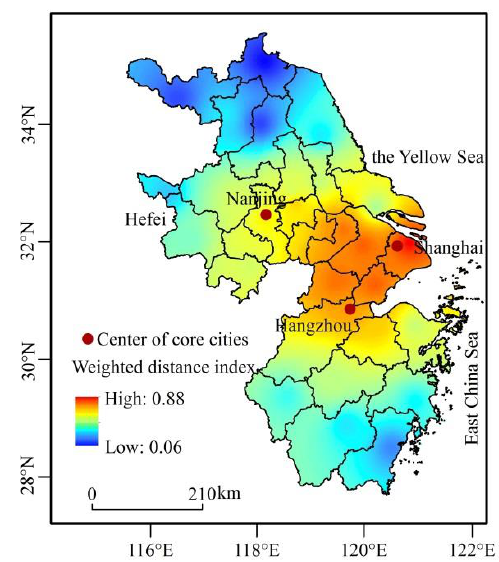
Figure 2. The spatial interpolation of weighted distance index Weighted distance index indicates the closeness to the core cities of YRD, ranging from 0.06: close to core cities to 0.88.